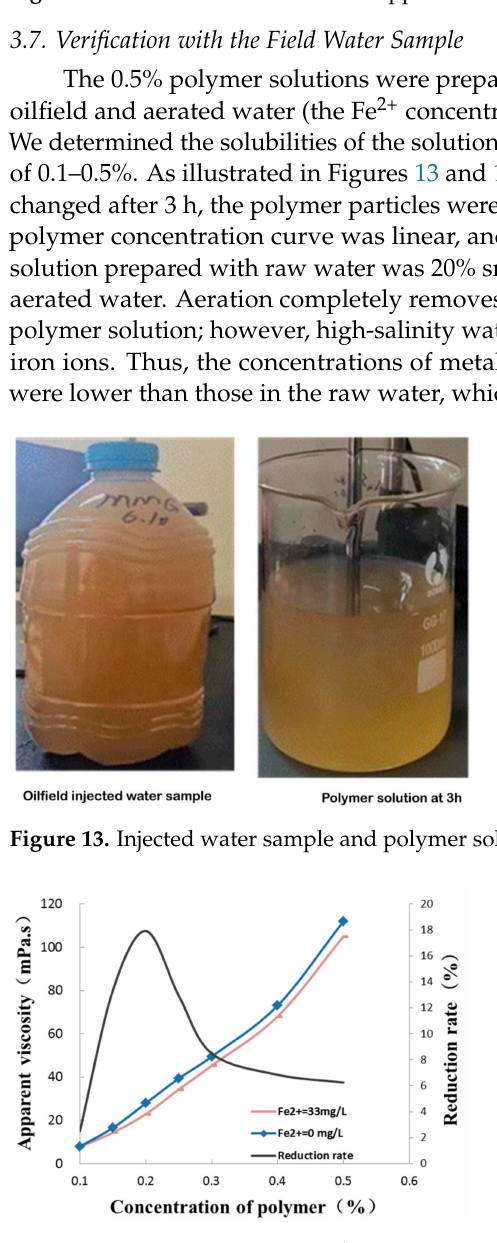
Figure 14. Apparent viscosity–polymer concentration